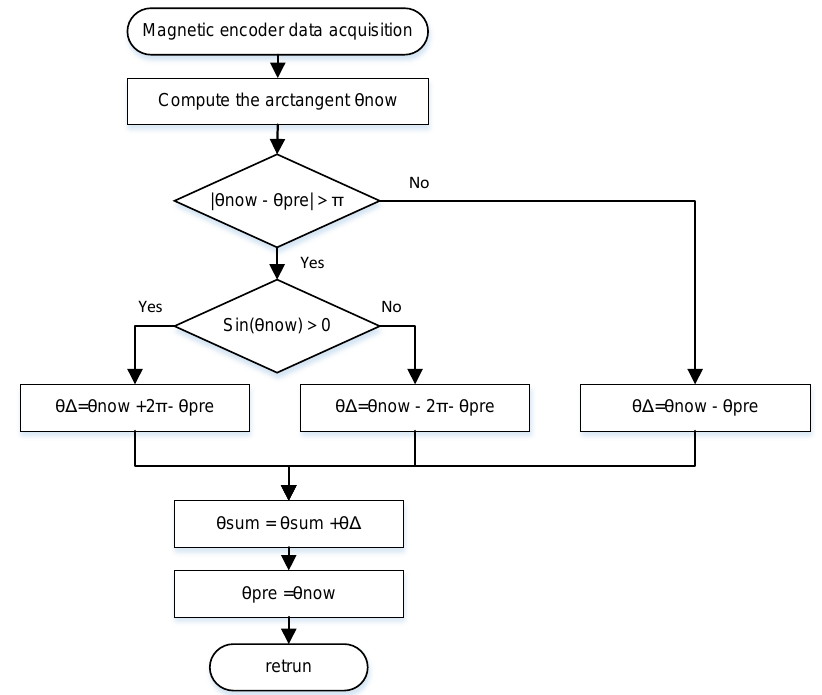
Figure 15. Flow chart of the magnetic encoder angle